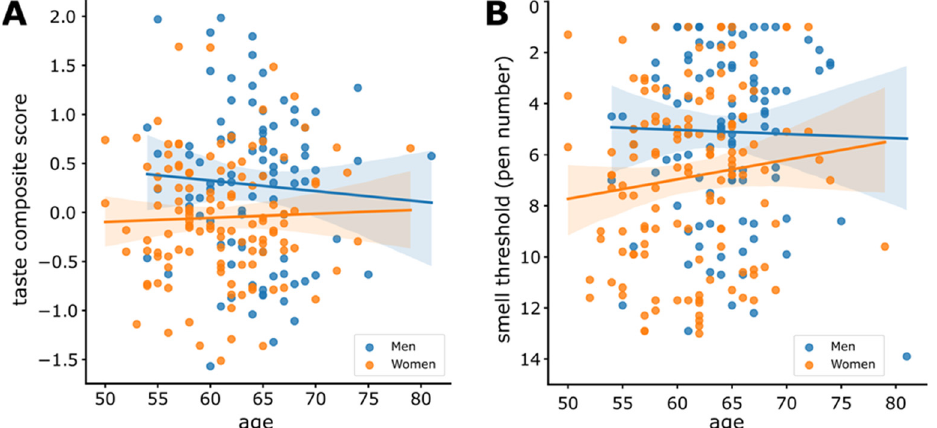
Figure 5. ( A ) Scatter plot with linear regression line of taste composite scores fitted across age. ( B ) Scatter plot with linear regression line of smell thresholds (pen number) fitted across age, for men and women separately. Shaded regions represent 95% CI. Each dot is an individual’s data point with color indicating gender.